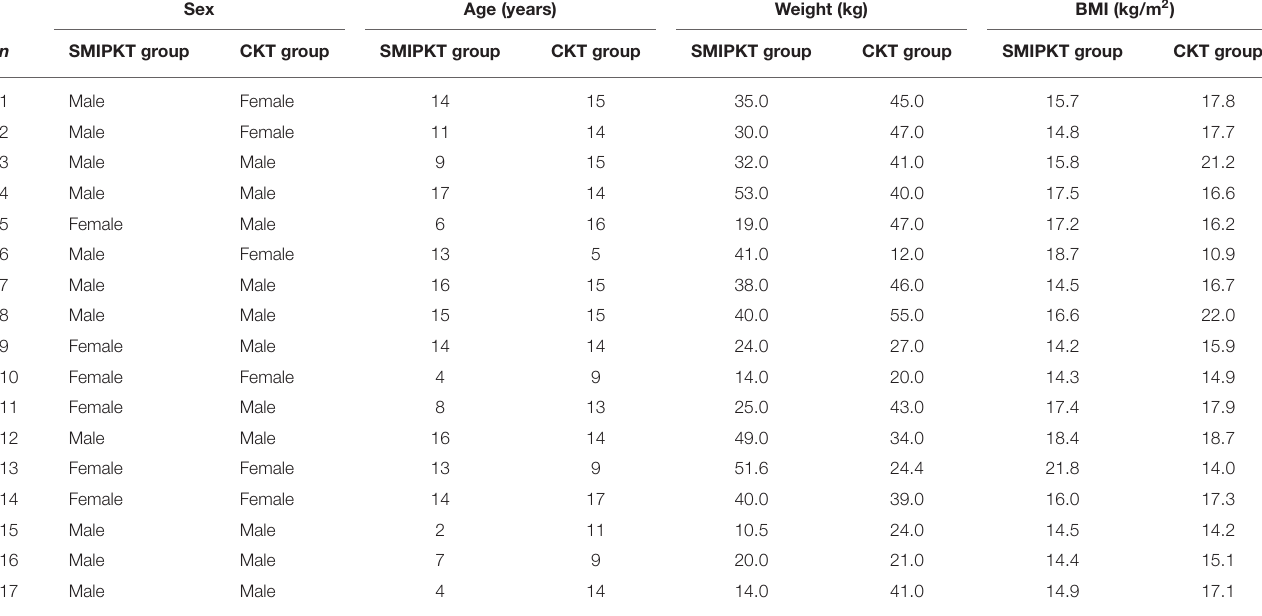
TABLE 2 | Detailed clinic characteristics of